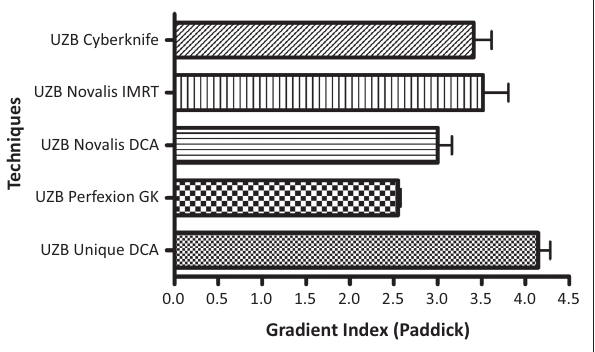
FIGURE 2: Paddick conformity index comparison between the Groote Schuur Hospital dynamic conformal arc technique and published results from Universitair Ziekenhuis Brussel for CyberKnife, Novalis intensity modulated radiotherapy, Novalis DCA and Perfexion GK